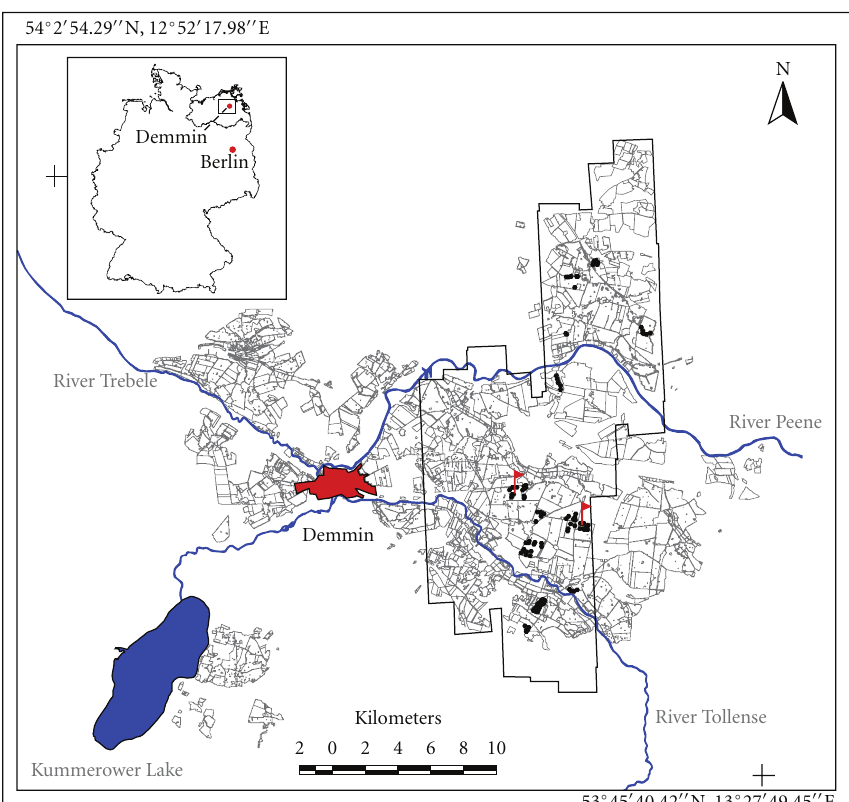
Figure 1: Location of the DEMMIN test site and its agricultural fields in the northeast of Germany near the city of Demmin. The black polygon outlines the maximum extent of the HyMap data acquired in the years 2004, 2005, and 2008. Sampling points are pictured as black circles. The red flags indicate the location of the two fields shown in Figure 13 (eastern flag) and Figure 14 (western